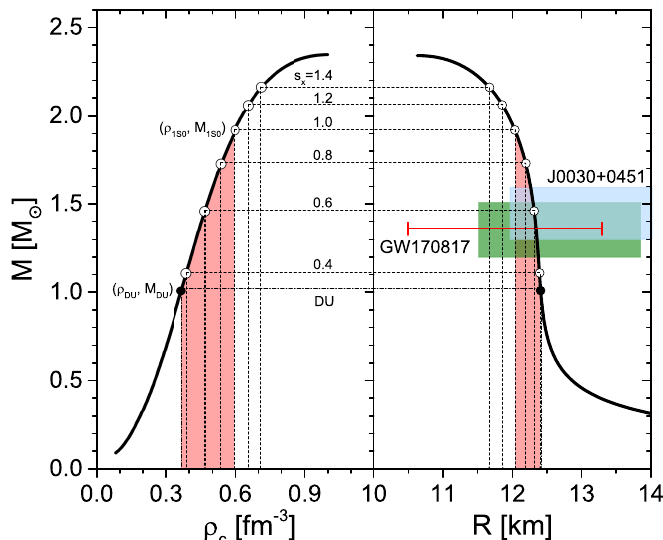
Figure 1. Neutron star gravitational mass vs central baryon density (left) and radius (right) for the V18 EOS. The density of the onset of DU cooling, ρ DU , and the one of the vanishing of the p1S0 BCS gap, ρ 1 S 0 , are indicated. The red-shaded region indicates blocking of the DU process. The effect on ρ 1 S 0 of the pairing-range parameter s x , Equation (13), is also shown. Some experimental constraints from NICER (blue area [48] or green area [49]) and GW170817 (red bar) [6] are